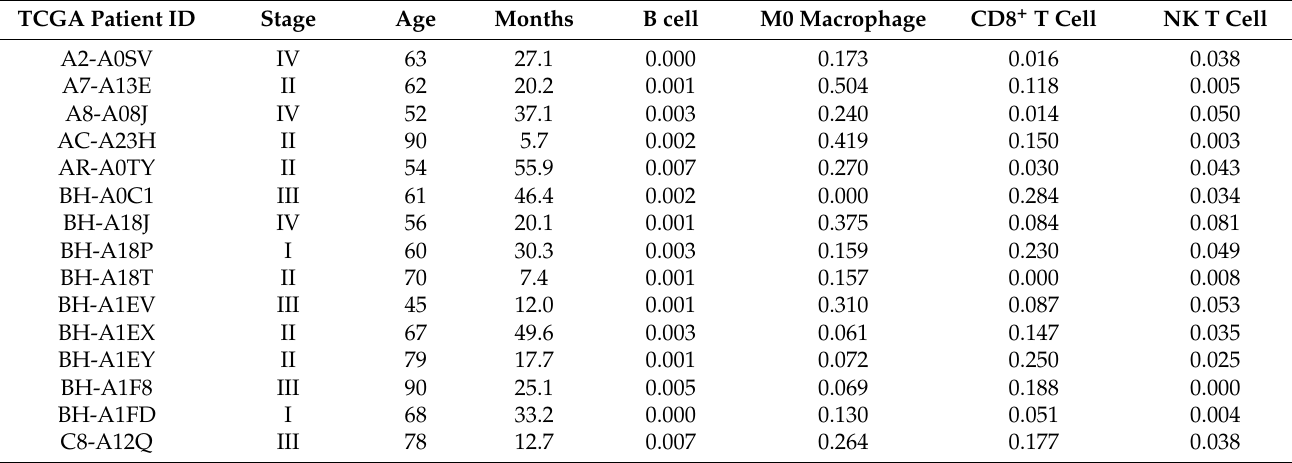
Table 3. Clinical and critical immune cell composition (identified via XAI) from bulk RNA-seq data of non-TNBC patients that survived for less than 5